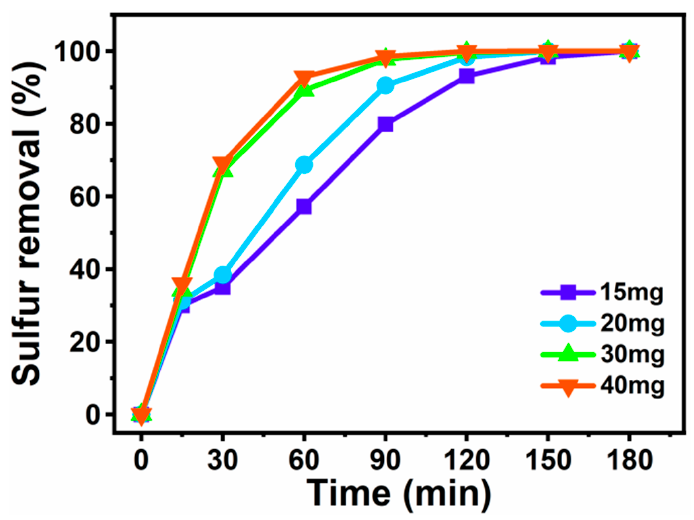
Figure 8. E ff ect of the amount of [BMIM] 3 PMo 12 O 40- based MCF on removal of DBT. Experimental conditions: T = 60 °C, V DBT = 5 mL, V IL = 3 mL, O/S = 6, and t = 3 h.